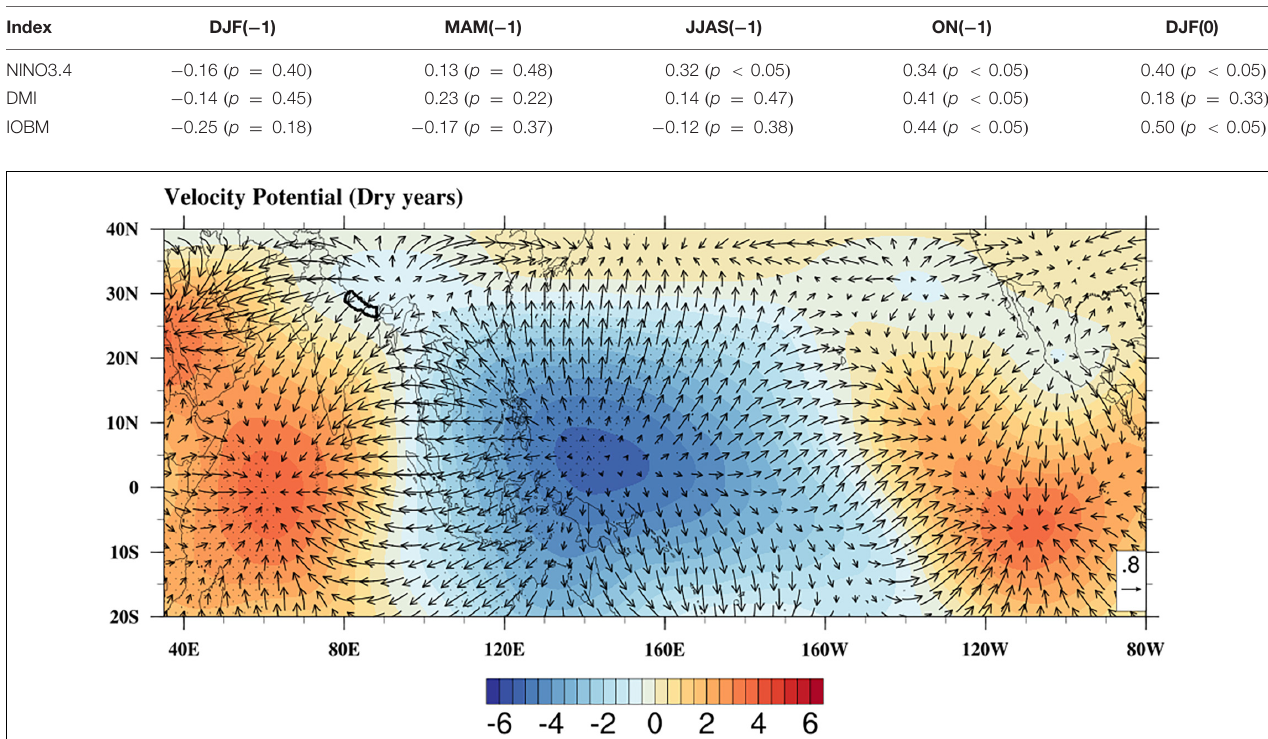
TABLE 2 | Lag correlation between winter precipitation, NINO3.4, DMI, and IOBM.